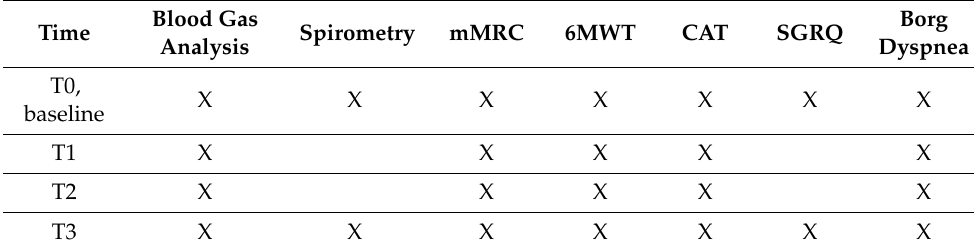
X indicates measurements evaluated at each assessment